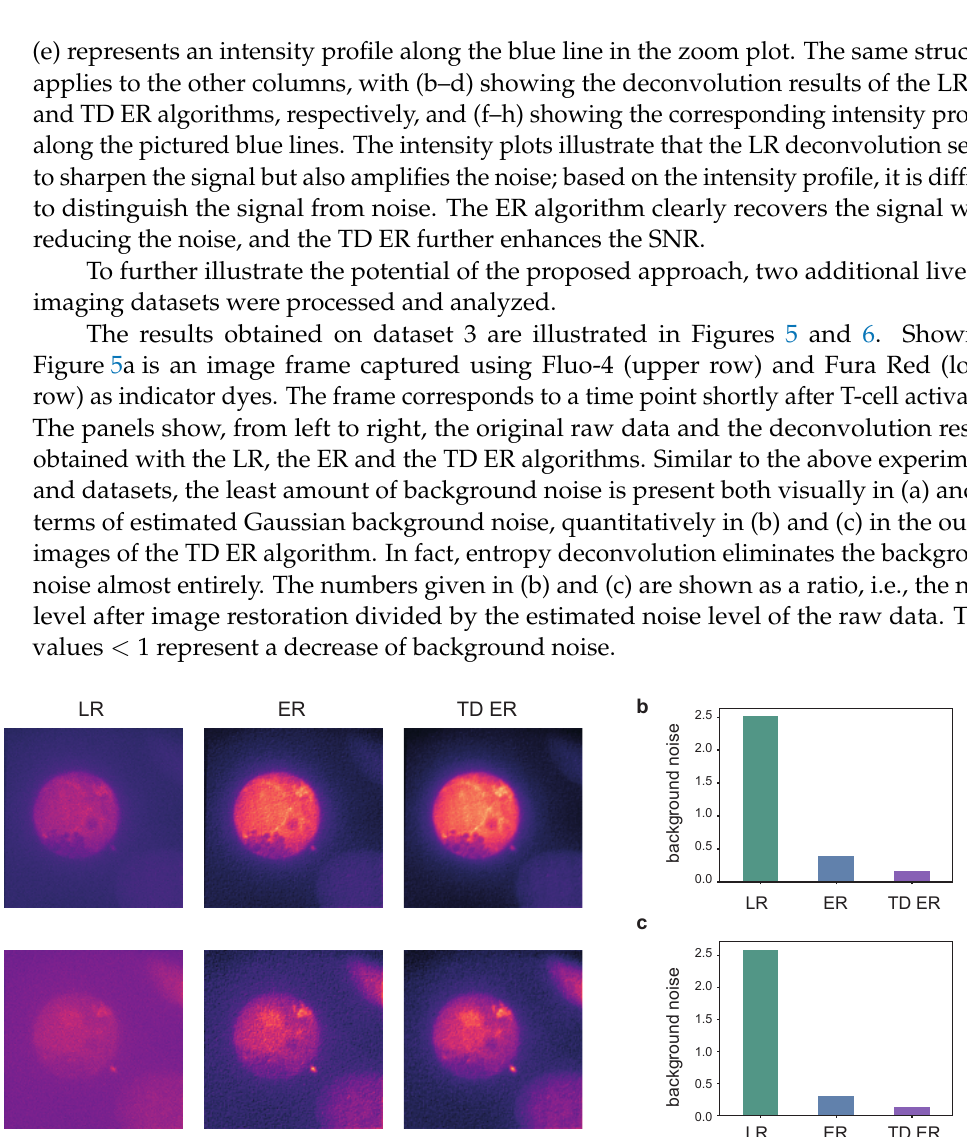
Figure 5. Panel ( a ): Deconvolution results for [ Ca 2 + ] i imaging and frames using Fluo-4 (upper row) and FuraRed (lower row) as the indicator dye. From left to right: raw image, LR, ER and TD ER result. Entropy-based deconvolution parameters were λ = 0.4 (TD ER: λ = 0.4, λ T = 0.4) and ε = 0.001. Panels ( b , c ) show the estimated background noise remaining in the deconvolved images, normalized to the background noise of the raw image for the different deconvolution